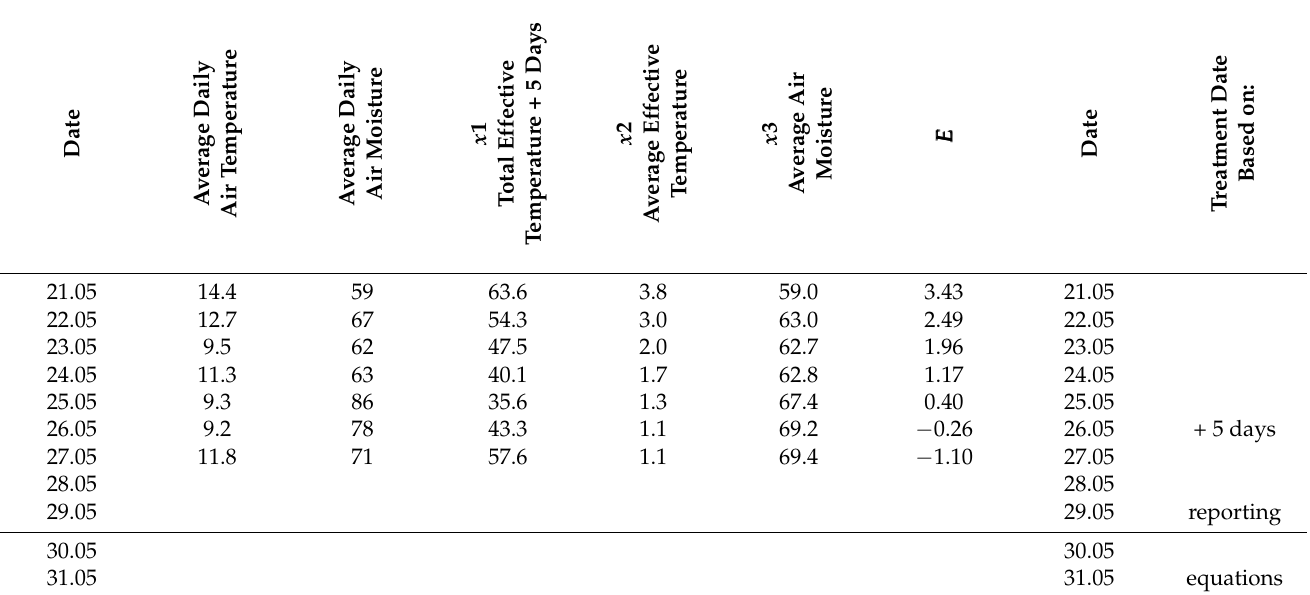
Table 6. Treatment date set for Babor ó wko in 2013 using multiple regression equation based on egg incubation time for both Oulema spp.